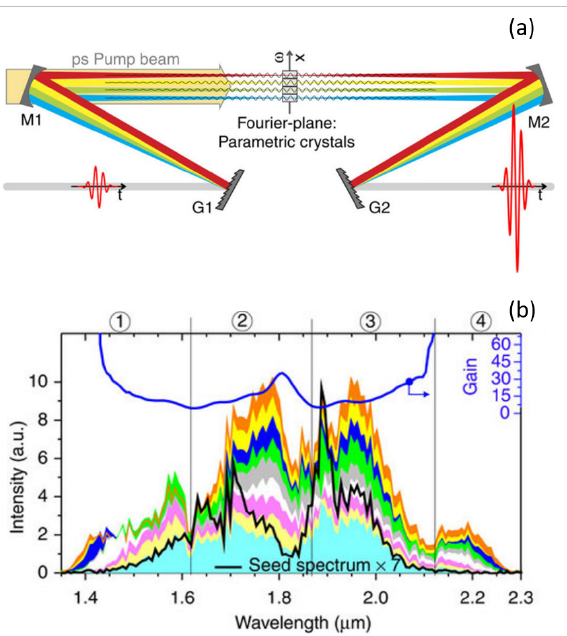
Figure 9. ( a ) Scheme of the Frequency-domain Optical Parametric Amplification (FOPA) system; ( b ) example of the amplified spectrum in the FOPA [53]. The black curve corresponds to the seed spectrum. The spectral ranges of the four BBO crystals used for the amplification in the Fourier plane are marked by vertical lines. The colored spectra correspond to amplification for different pump levels. The blue curve corresponds to the experimental gain curve. Adapted with permission from [53], Copyright NPG,